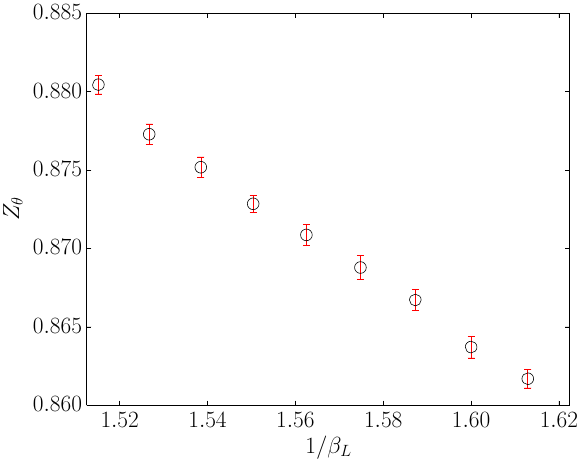
Figure 6 . Z θ results obtained for N = 21. Data are plotted against 1 /β L since deviations of Z θ from 1 can be expanded in powers of 1 /β L [21]. Note that the values of Z θ obtained in this work are much closer to 1 than those obtained in SU( N c ) Yang-Mills theories, see, e.g., ref.